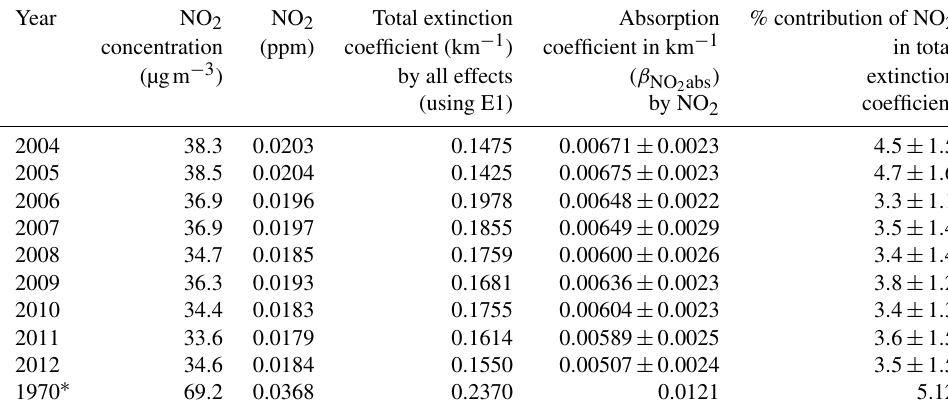
Table 3. Gas contribution to visibility change over Heathrow